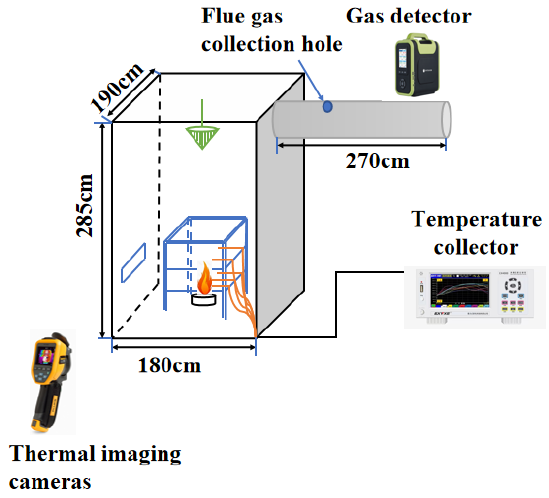
Figure 1. Device diagram of the experimental system.